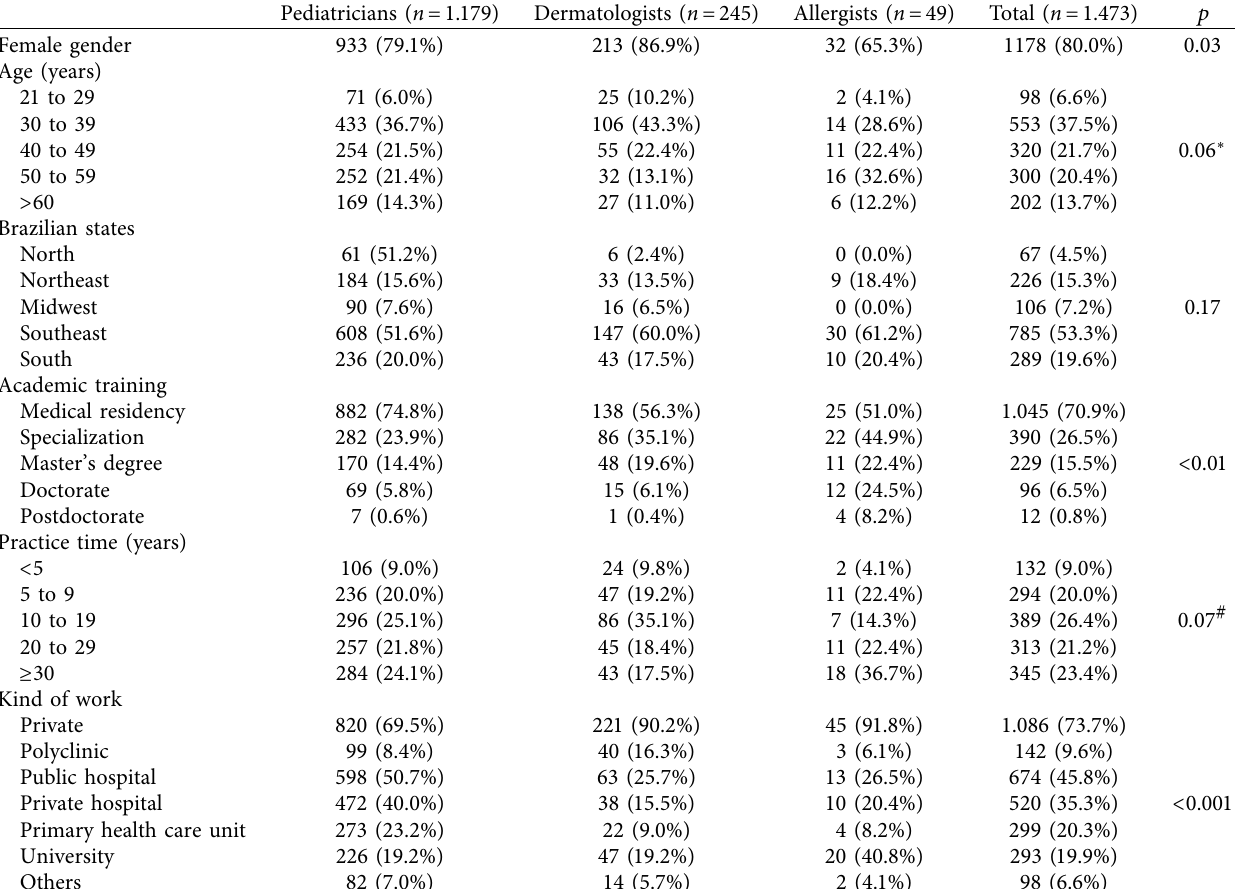
Table 1: Sociodemographic data according to the different